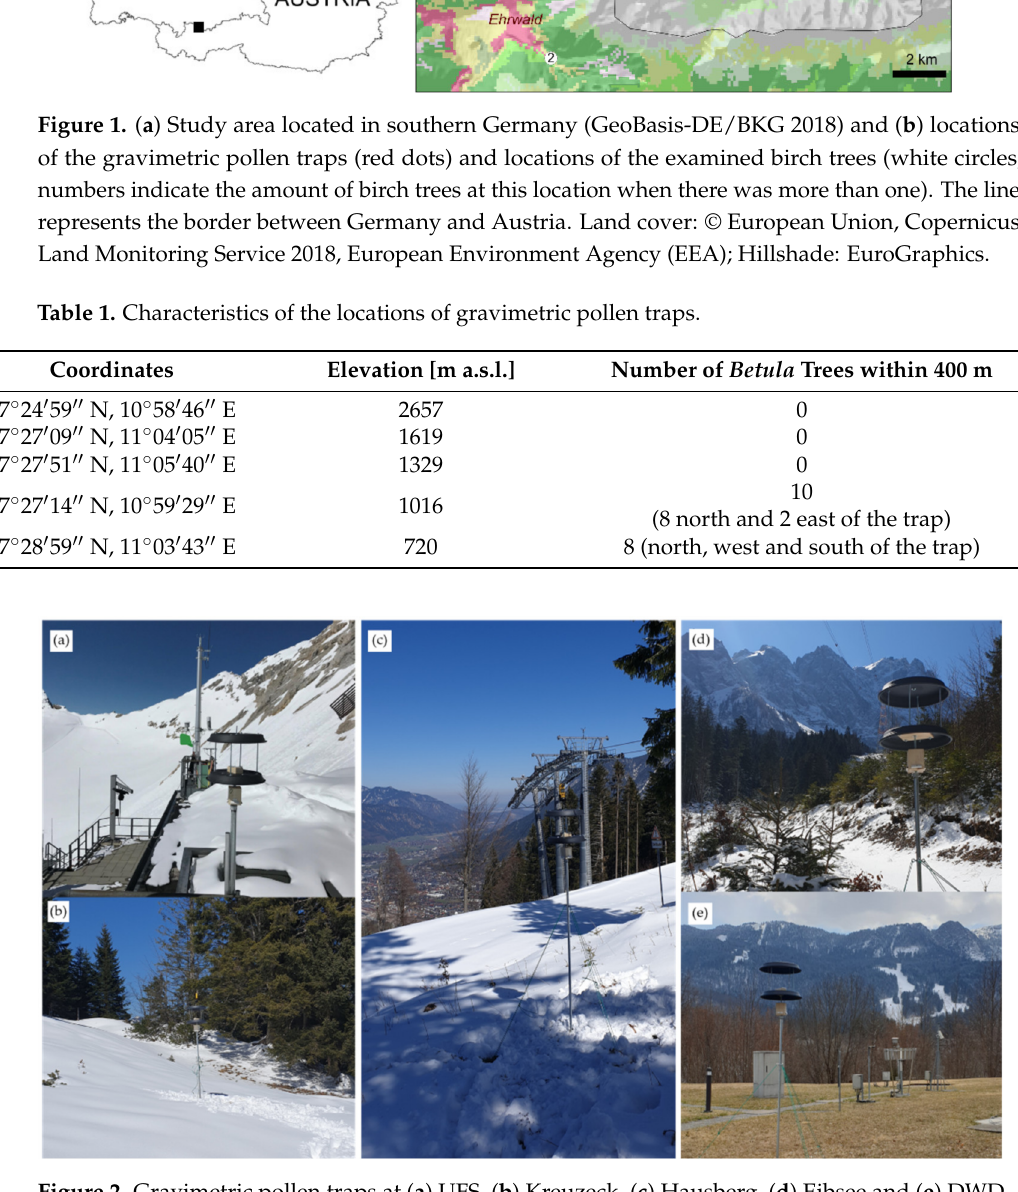
Figure 2. Gravimetric pollen traps at ( a ) UFS, ( b ) Kreuzeck, ( c ) Hausberg, ( d ) Eibsee and ( e )